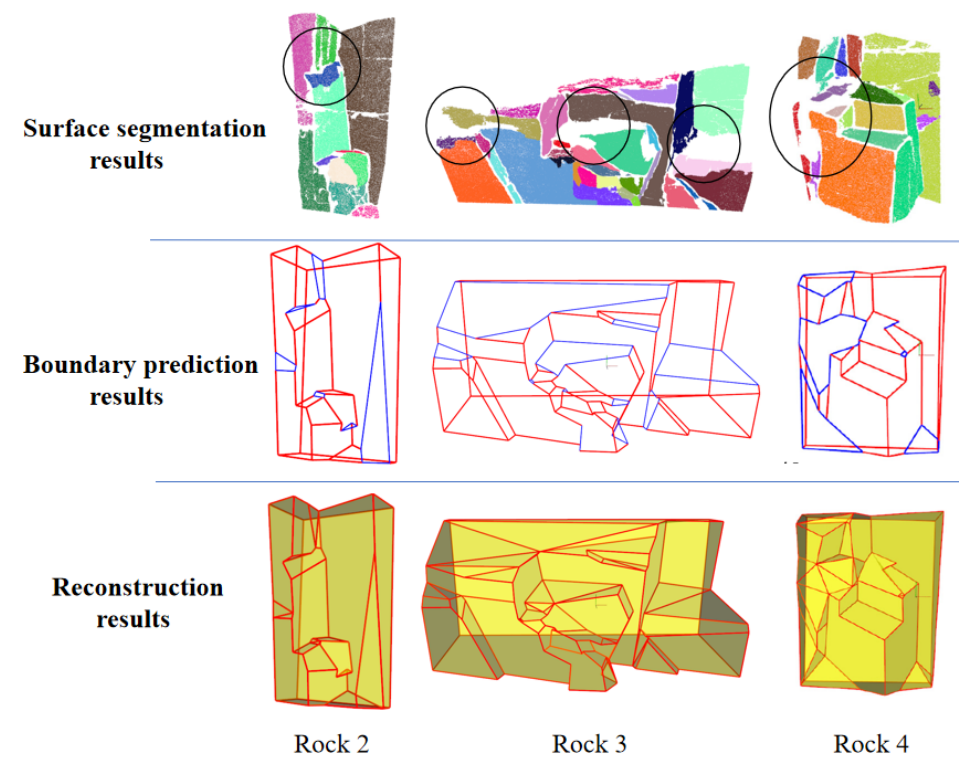
Figure 14. Tests on datasets with poor data quality. Obvious information loss areas are marked by black